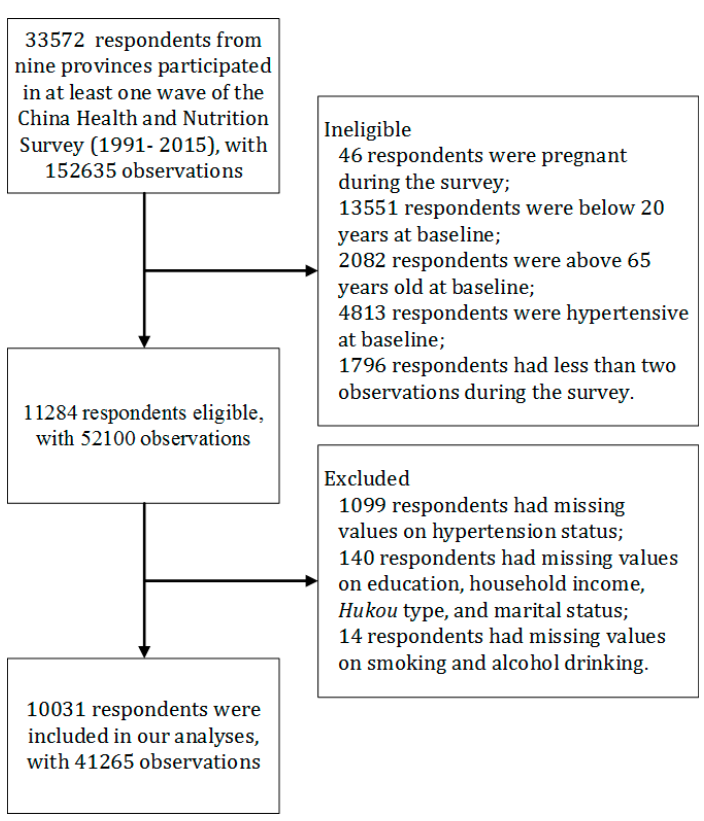
Figure 1. Sample selection process.